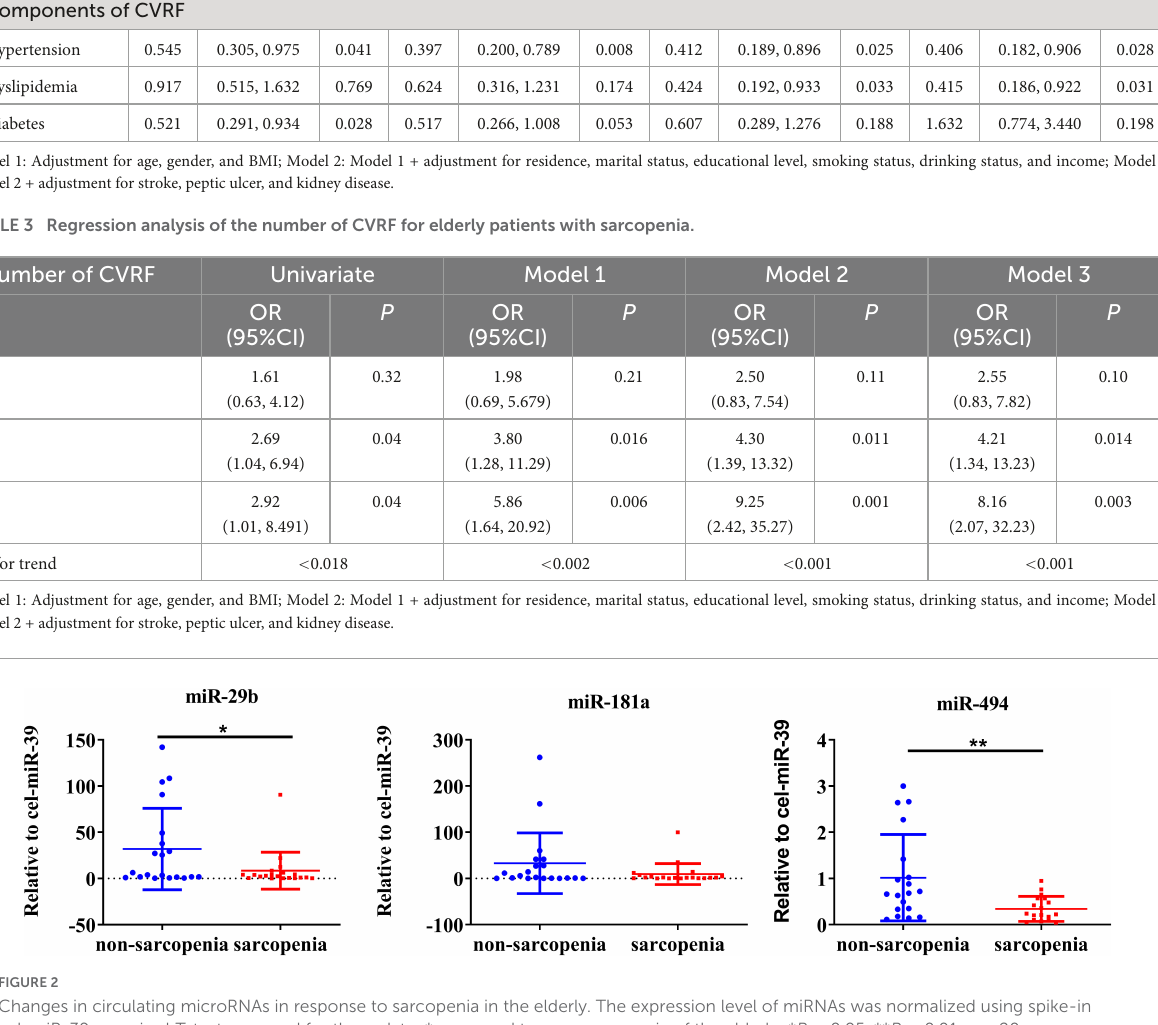
Presence of CVRF